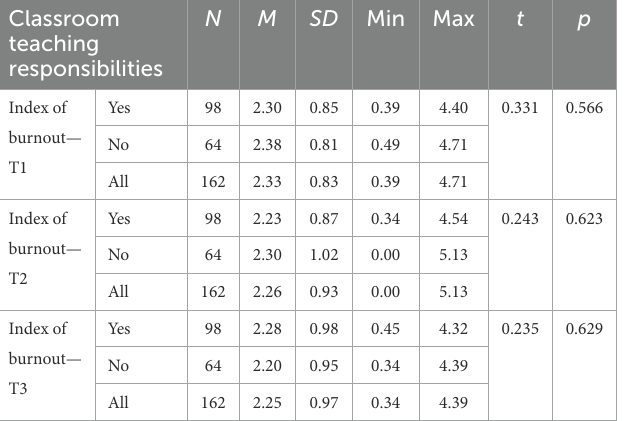
TABLE 7 Descriptive statistics and averages of burnout index comparison between teachers who take on a classroom task and teachers who do not at three time points.